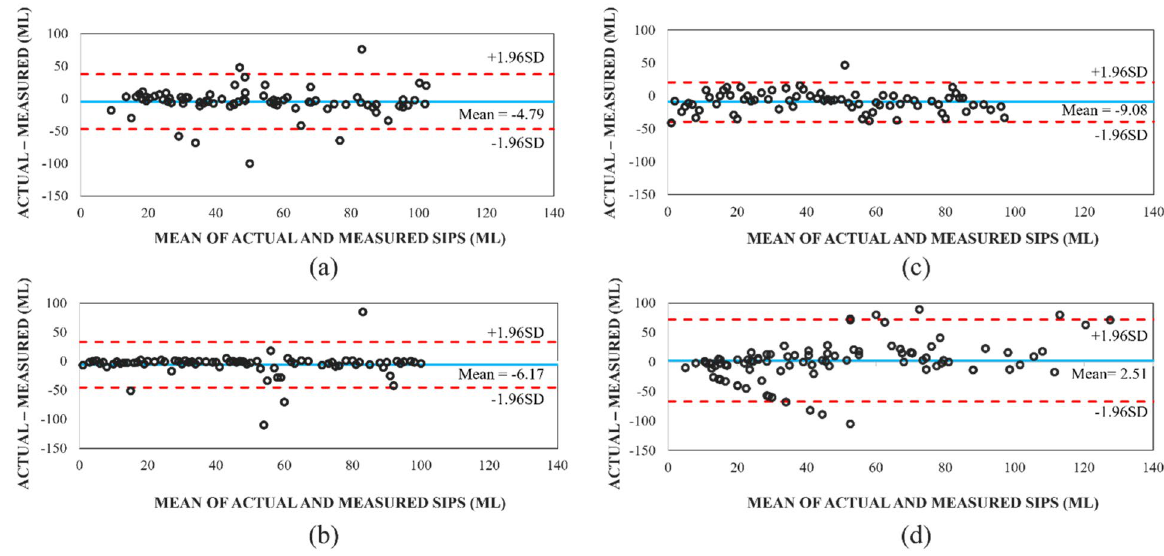
Figure 2. Bland–Altman plots for ( a ) H2OPal, ( b ) HidrateSpark Steel, ( c ) HidrateSpark 3, and ( d ) Thermos Smart Lid. The dotted lines represent the confidence intervals around the mean, calculated from the standard deviation in Table